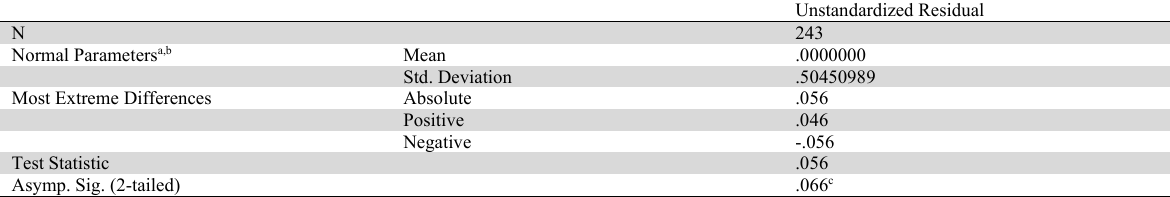
Normality test with One Sample Kolmogorov Smirnov Test